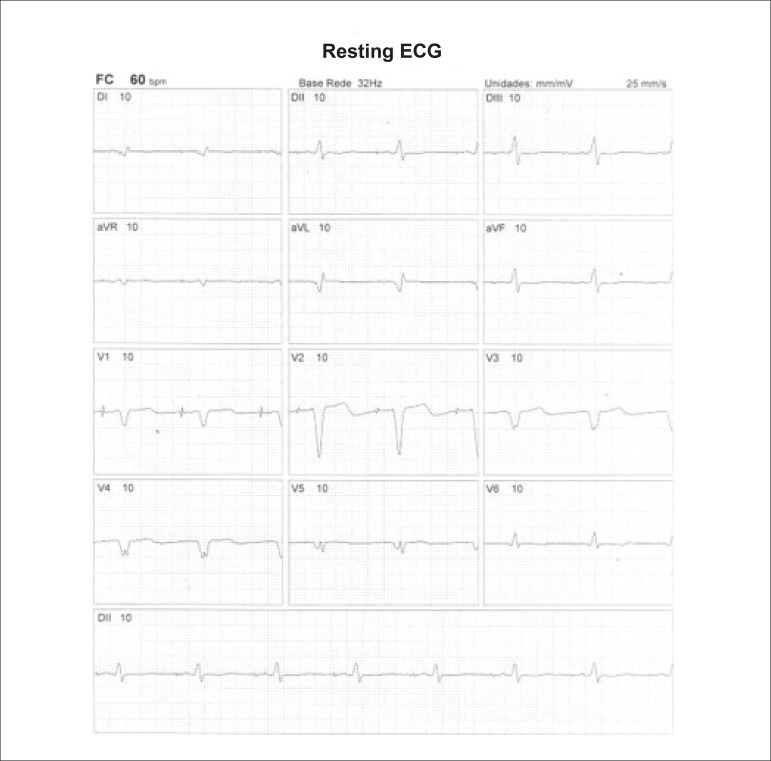
Case 7 - Electrocardiogram tracing of patient with artificial pacemaker.